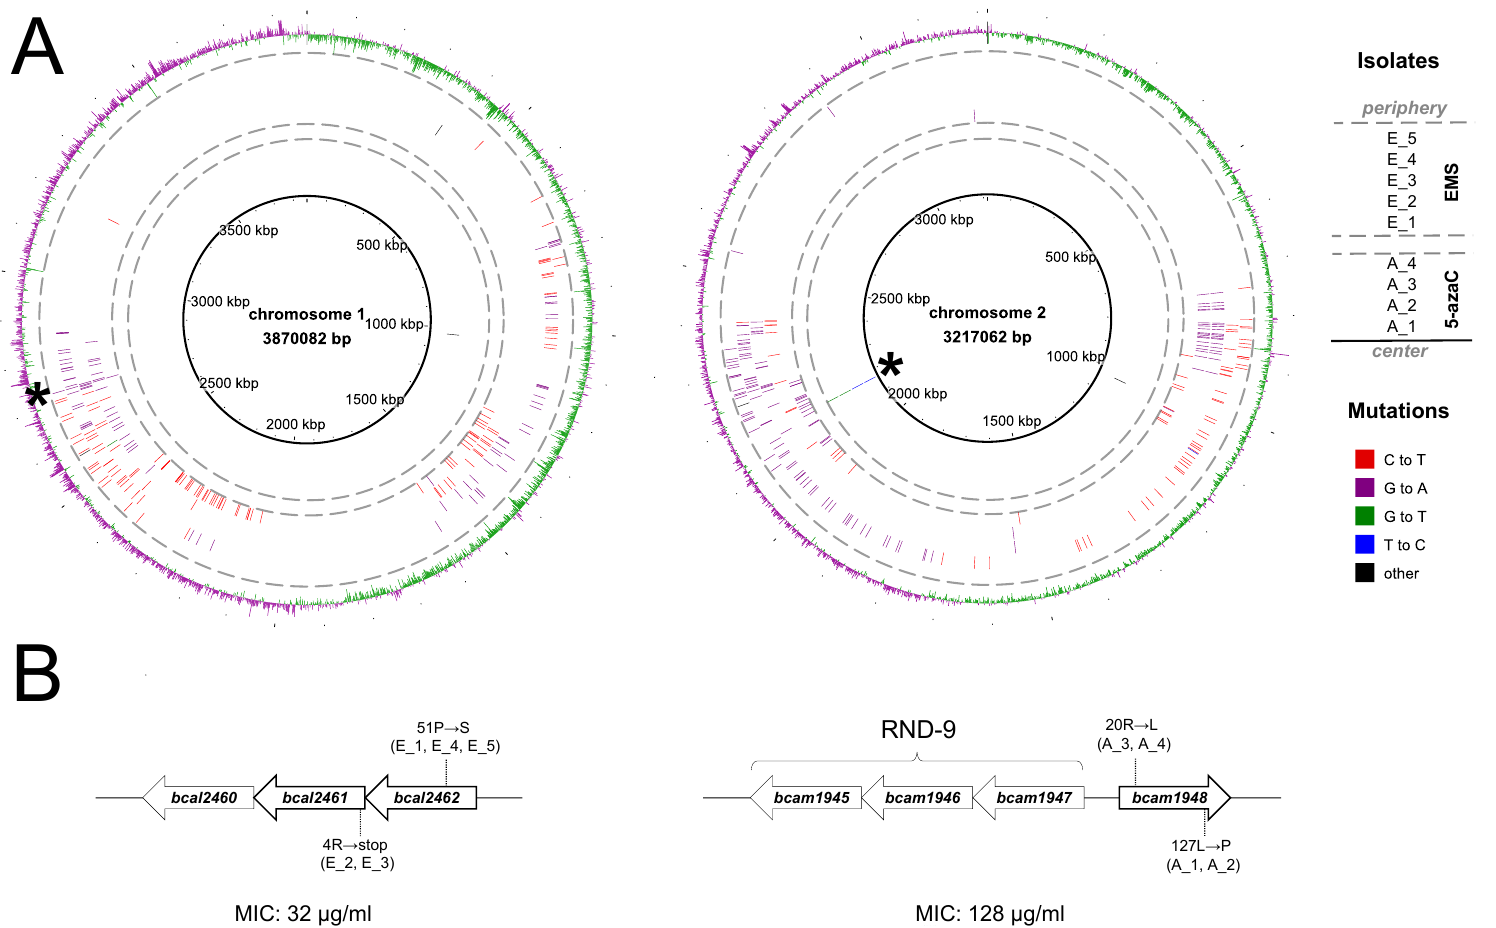
Figure 1. Mutations in B. cenocepacia isolates resistant to 11026103. ( A ) All mutations, mapped to chromosomes 1 and 2, which resulted from chemical mutagenesis with ethyl methanesulfonate (EMS) (five isolates; outer circles) or 5-azaC (four isolates; inner circles). The genes / operons which displayed convergent mutations are denoted by asterisks. ( B ) Detailed view of parallel mutations. MICs of corresponding 11026103-resistant mutants are denoted. The visualizations were carried out using the BRIG software